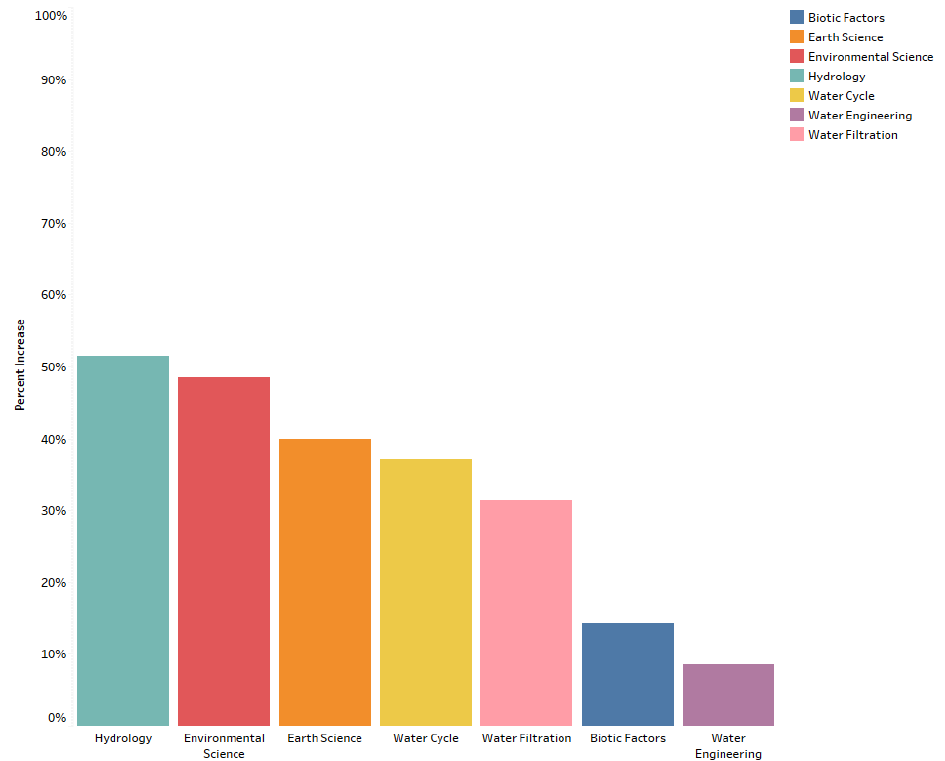
Figure 2. Total Increase in Water Component Conceptual Understanding- All Students ( n = 56). Average percent increase for water component conceptual understanding after experiential water unit intervention. All Students, Avenue School, 2016 – 2017.